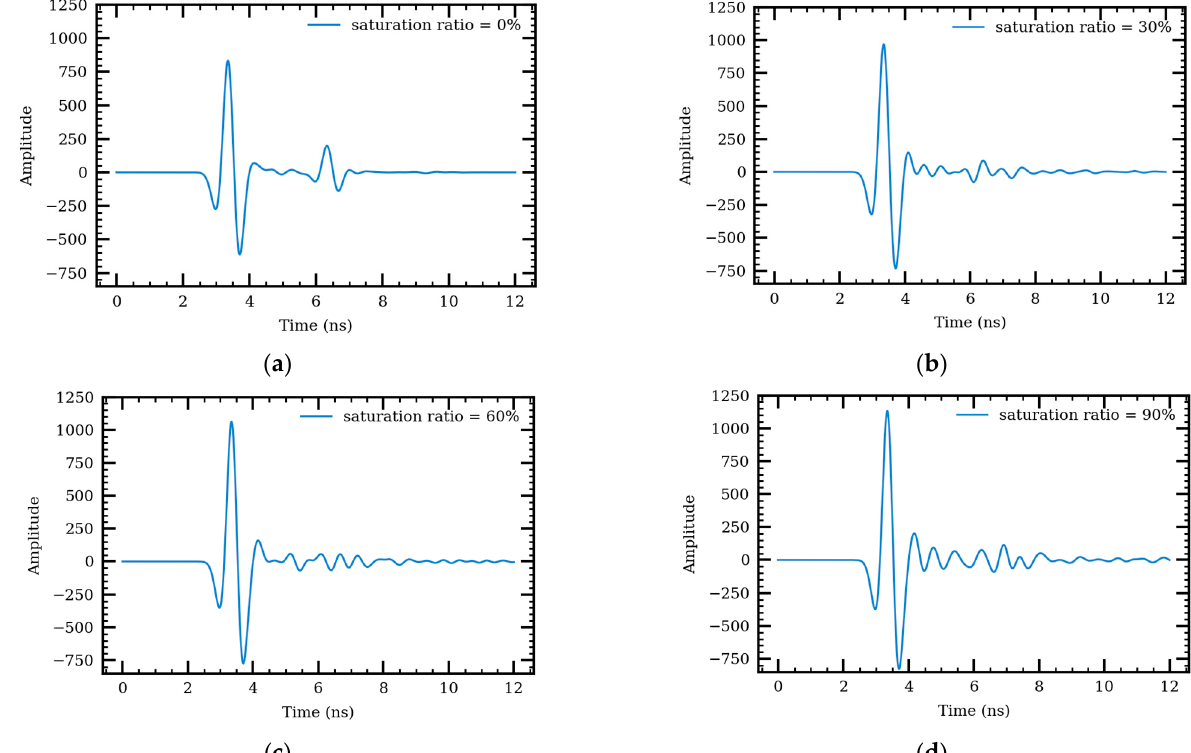
Remote Sens. 2021 , 13 , x FOR PEER REVIEW 11 of 17 Figure 9. GPR signals on pavement with different saturation ratios of ( a ) 0% ( b ) 30% ( c ) 60% ( d ) 90%.